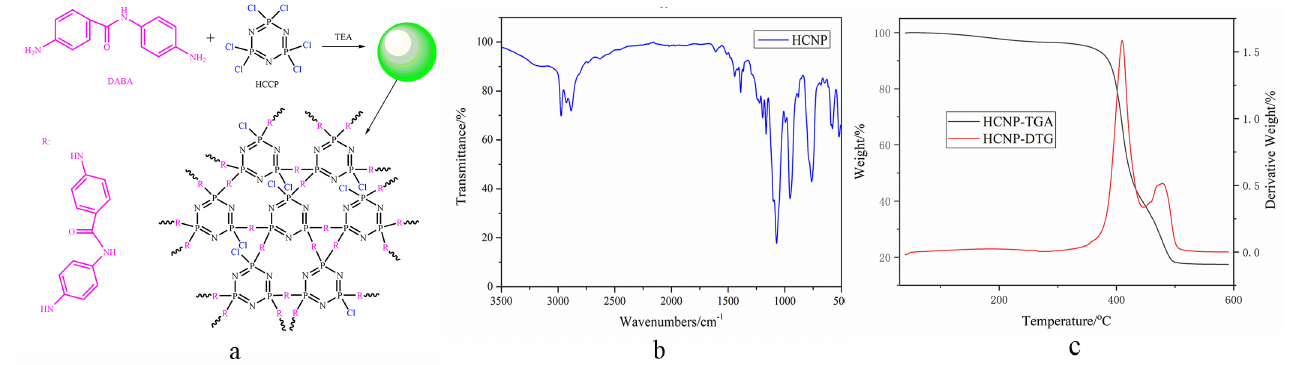
Figure 1. The synthetic routes and FTIR spectra of HCNP. ( a ) The synthetic routes of HCNP, ( b ) the FTIR spectra of HCNP, and ( c ) the TGA curves of HCNP.